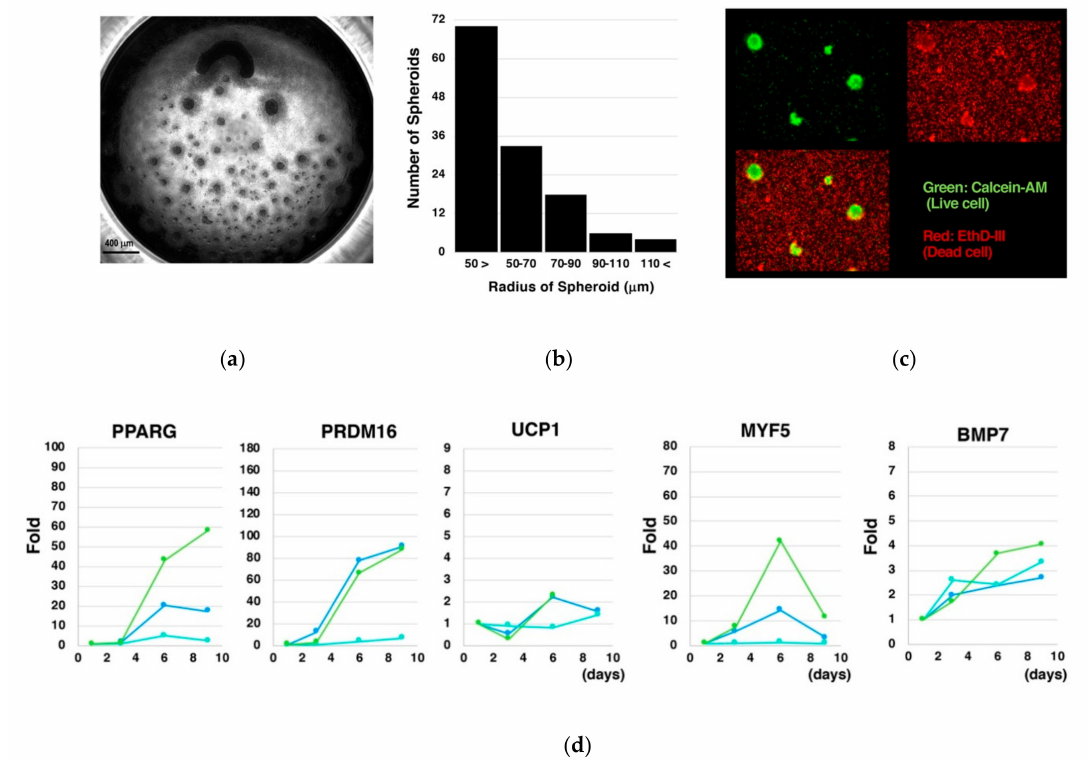
Figure 6. Generation of spheroids by a conventional massive floating culture lowers the e ffi ciency of the di ff erentiation under a cytokine-free condition. Single cell-dissociated hESCs were cultured in a 96-well flat bottom low attachment plate. Observations under phase contrast microscopy ( a ) and histogram analyses of the spheroid size ( b ) indicated that spheroids of diverse sizes with irregular shape were created. Staining with a live cell probe and a dead cell probe ( c ) showed that there were abundant dead cells which were not incorporated into spheroids. Examinations on gene expression kinetics indicated that fold inductions of the genes for BA makers ( PPARG , PRDM16 , UCP1 ), a myoblast marker ( MYF5 ), and a BA inducer ( BMP7 ) ( d ) were reduced compared to Figure